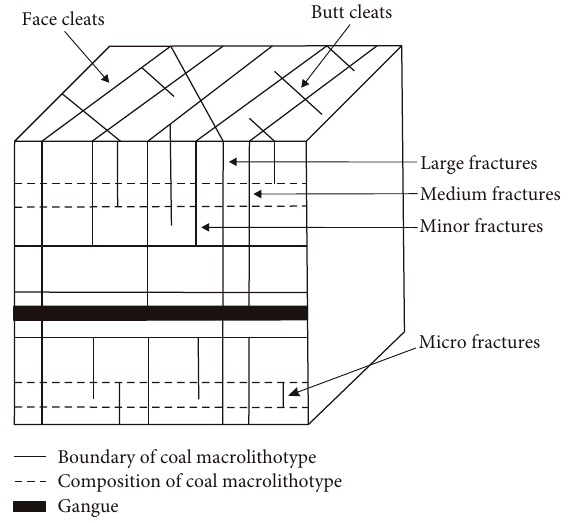
Figure 1: Classi fi cation of coal seam fractures